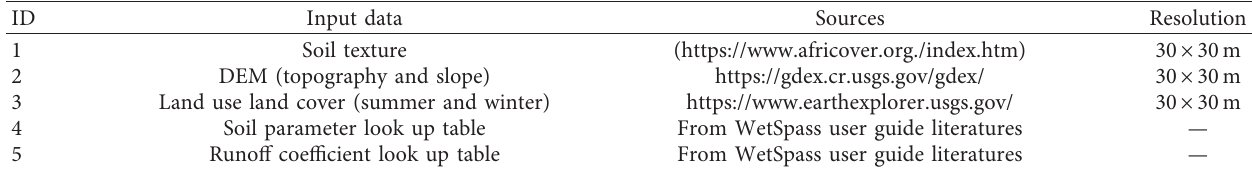
Table 4: Available soil, land use, and DEM data within the study